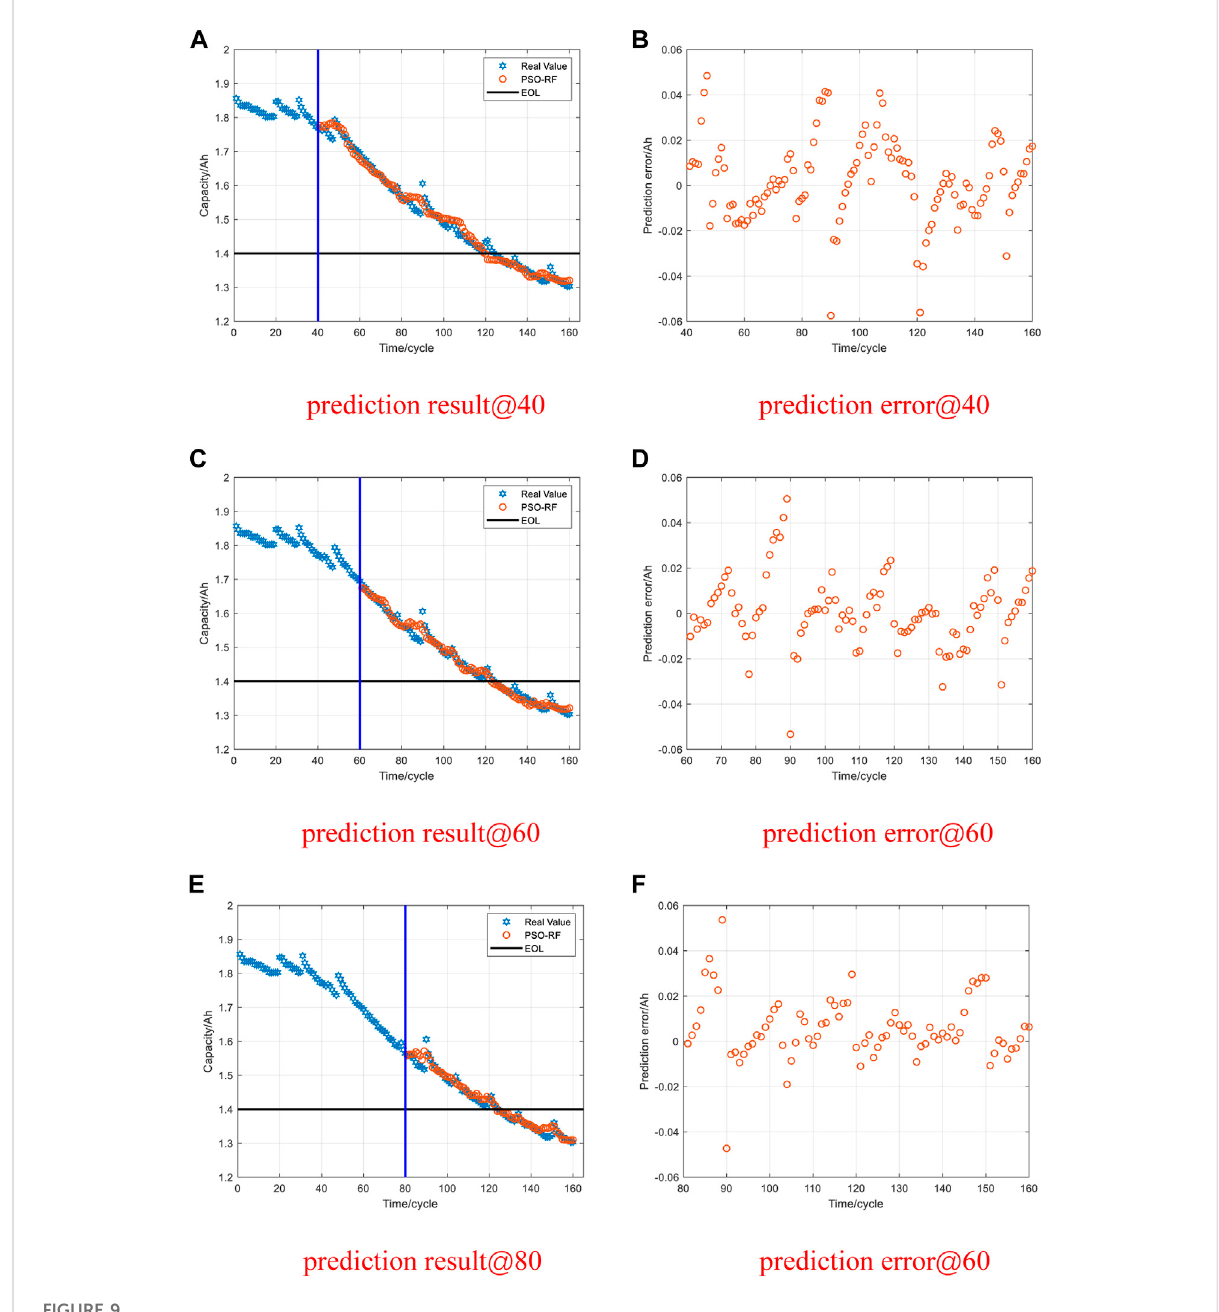
FIGURE 9 Results and errors of B0005